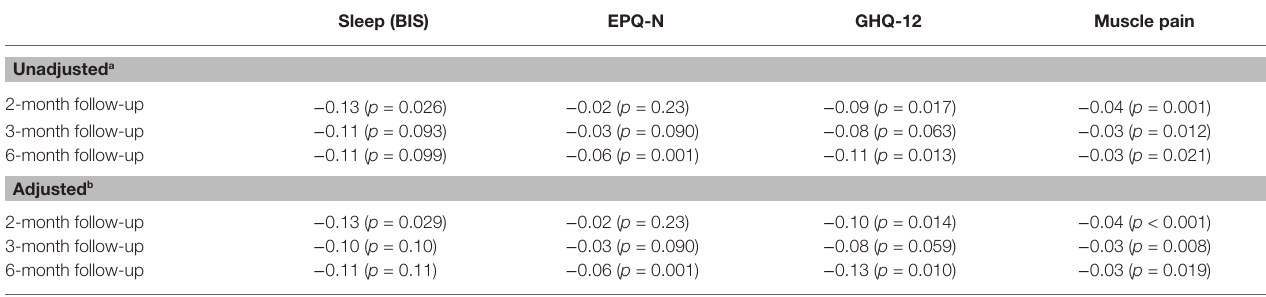
TABLE 3 | The moderating effect of LSI on the difference between the effects on outcome from baseline to follow-up in the intervention group compared to the control group. Sleep